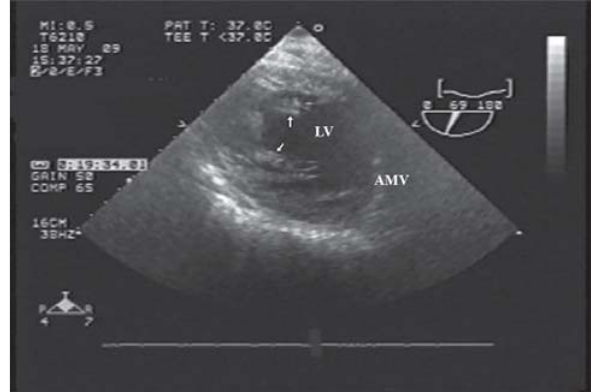
Fig. 2 - Thick strands of residual thrombotic material attached to chordae. Arrows point to residual thick fibrin strands, enmeshed in the chordae of the mitral valve. LV: left ventricle. AMV: anterior leaflet of mitral